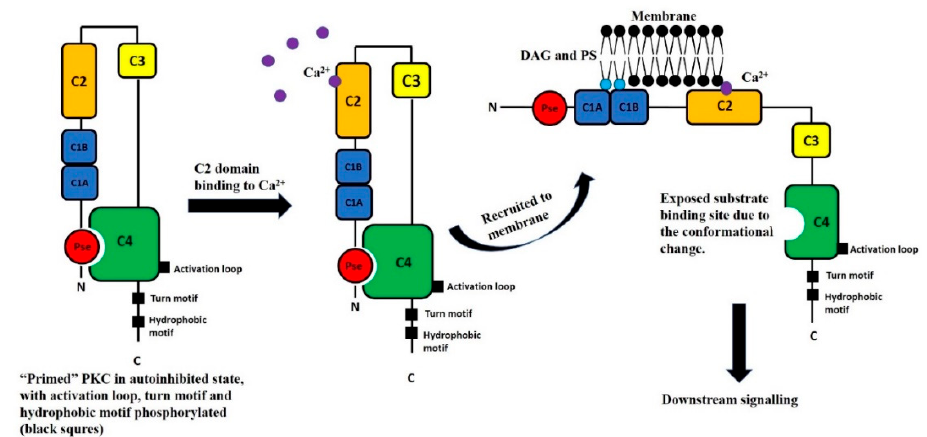
Figure 2. Schematic drawing of the activation steps of cPKCs. Following the three distinct phosphorylations at the activation loop, the turn motif, and the hydrophobic motif (for example, in human PKC β -II, corresponding to threonine 500, serine 641, and threonine 6601, respectively), PKCs are released into the cytosol, but with the pseudosubstrate occupying the substrate-binding site. Binding to Ca 2+ , PS, and DAG results in membrane translocation and subsequent conformational change, which releases the pseudosubstrate from the substrate-binding site.